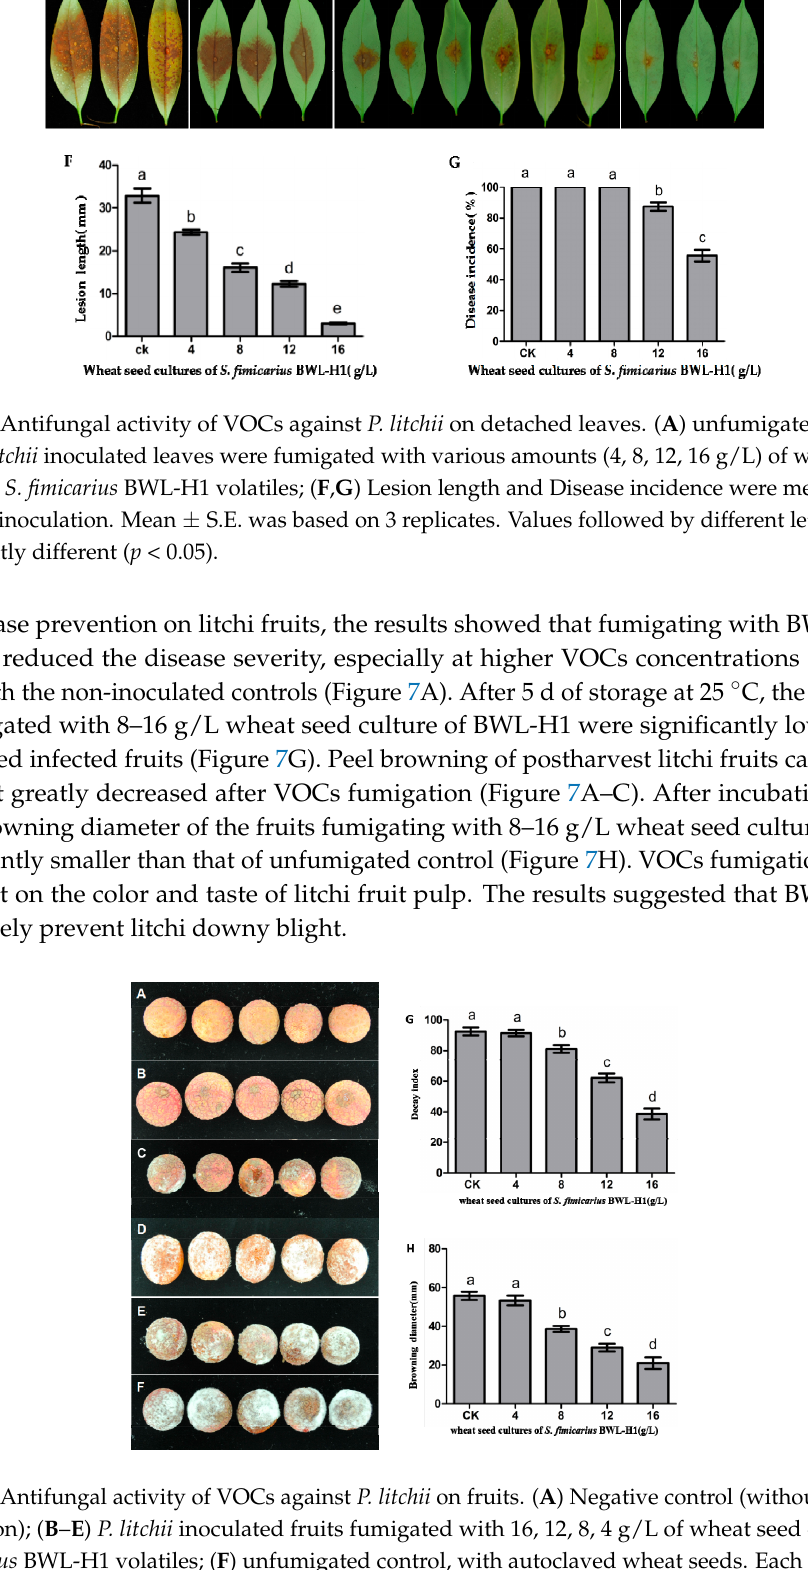
Figure 7. Antifungal activity of VOCs against P. litchii on fruits. ( A ) Negative control (without P. litchii inoculation); ( B – E ) P. litchii inoculated fruits fumigated with 16, 12, 8, 4 g/L of wheat seed culture of S. fimicarius BWL-H1 volatiles; ( F ) unfumigated control, with autoclaved wheat seeds. Each treatment consisted of three replicates with 30 fruits in each replicate; ( G , H ) Decay index and browning diameter of harvested litchi fruits inoculated with P. litchii after 5 d storage at 25 ◦ C. Data are the mean ± S.E. from three replicates per